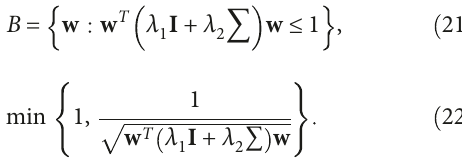
Algorithm 2 embeds the structure information into